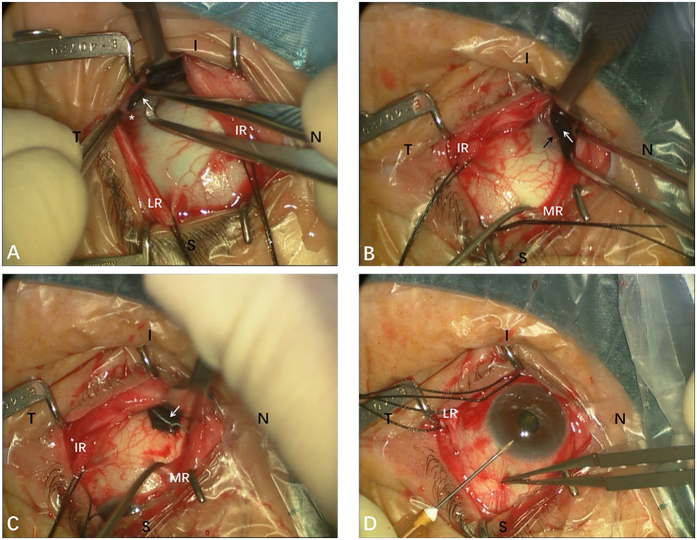
Intraoperative photographs of the posterior scleral contraction (PSC) surgery in one case (Left eye).(A) With the assistance of the traction sutures, the sclera strip (white arrow) was passed underneath the inferior oblique, next to the insertion point of the inferior oblique (asterisk). (B) The sclera strip (white arrow) was passed underneath the inferior rectus with caution, efforts were made to protect vortex vein (black arrow) from damage. (C) The inferior nasal end of sclera strip (white arrow) was fixed to the pre-equatorial sclera, 2 mm behind and outside the insertion point of the medial rectus (MR) muscle. (D) A 25-gauge syringe needle (1 mL) was inserted into the superior anterior chamber to release the aqueous humor. S: superior; I: inferior; N: nasal; T: temporal; LR: lateral rectus; IR: inferior rectus; MR: medial rectus.